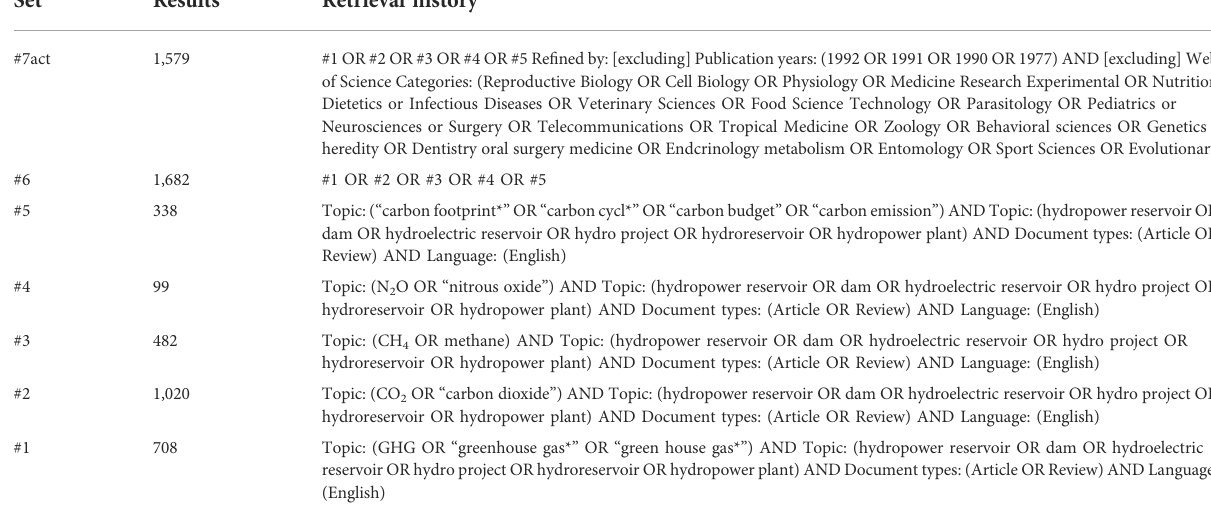
TABLE 1 Key word retrieval history for